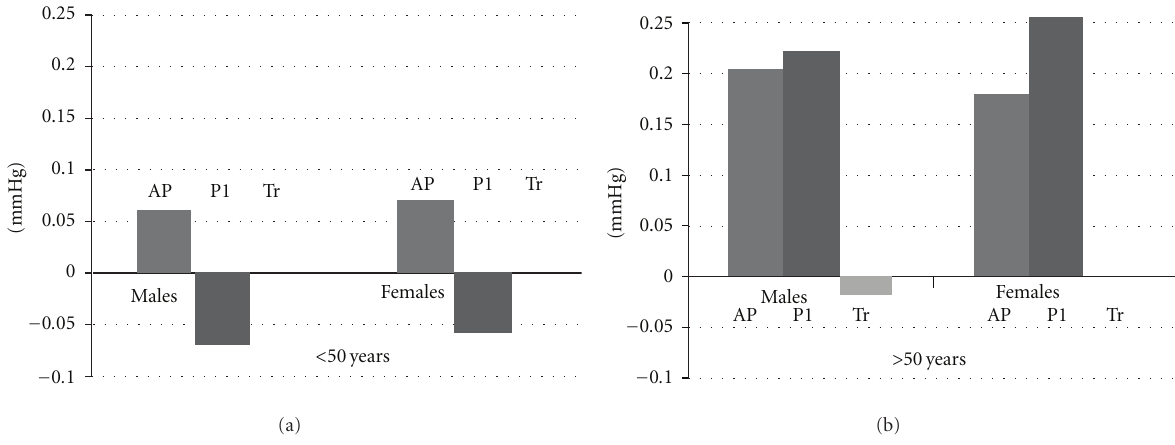
Figure 4: Gender-wise contribution of augmented pressure (AP), incident pressure (P1), and round trip travel time (Tr) to aortic pulse pressure before and after 50